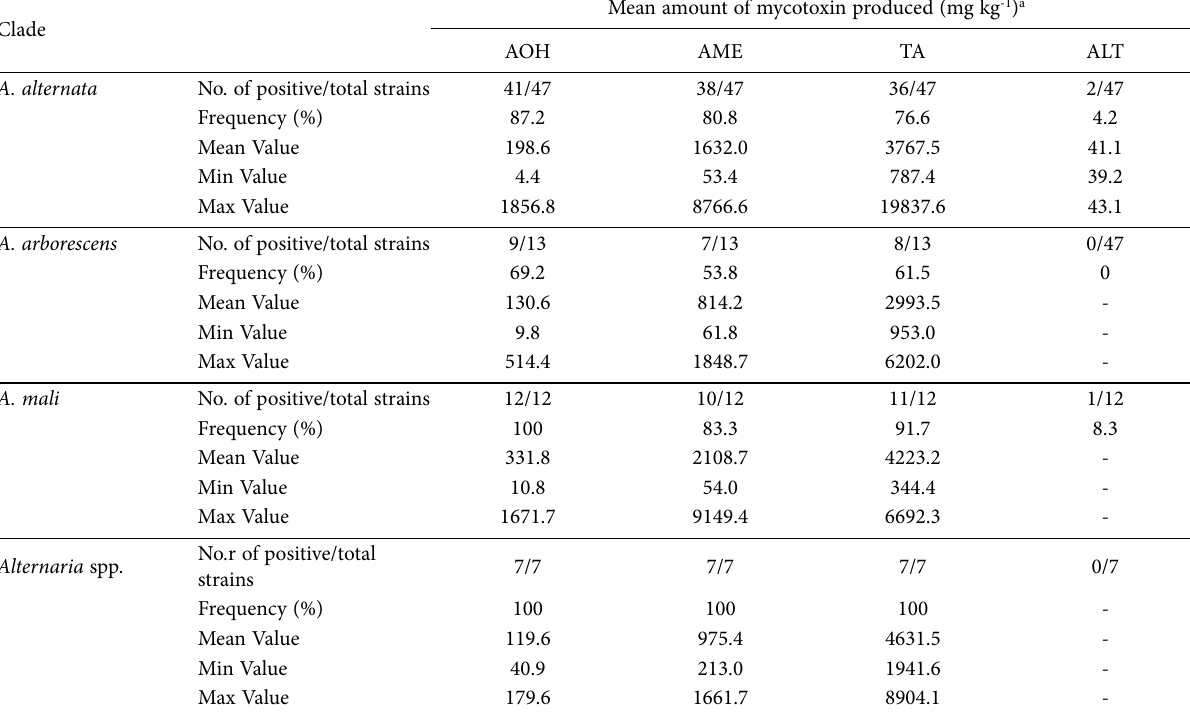
Table 1. Mycotoxin production and mycotoxin incidence for different phylogenetic Alternaria clades. Proportions of strains, and mean amounts of four mycotoxins, are indicated of each clade